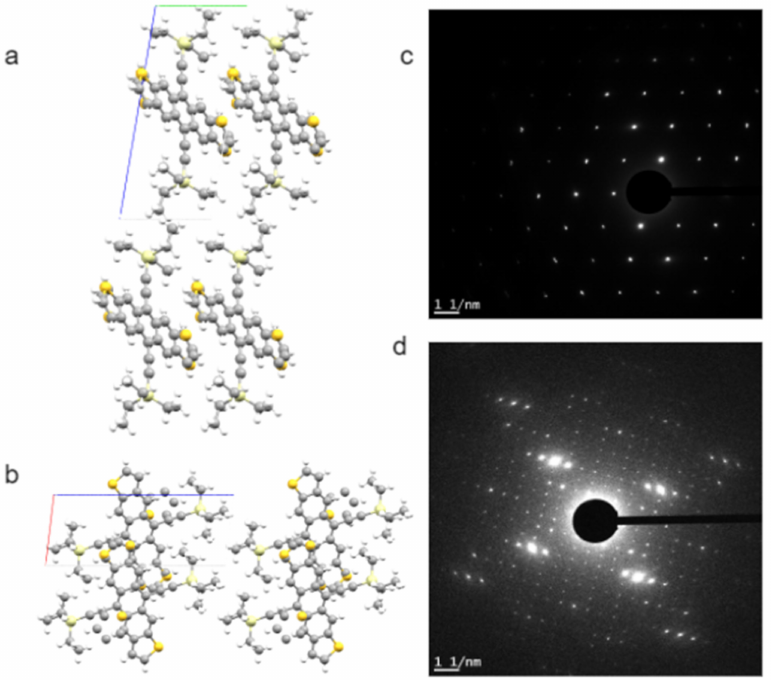
Figure 4. Bulk crystal structure of p-type small molecule organic semiconductor TES ADT: ( a ) viewed down a axis, and ( b ) down b axis. The a, b, and c axes of the unit cell are in red, green, and blue, respectively. This bulk crystal structure corresponds well to the [001] zone SAED patterns of TES ADT crystalline thin films grown from THF ( c ). Hexane solution will induce a polymorph that is much larger in unit cell sizes, as indicated by the [001] zone SAED patterns in ( d ). The simulated views and SAED patterns shown here are unpublished results related to the work reported in [73].